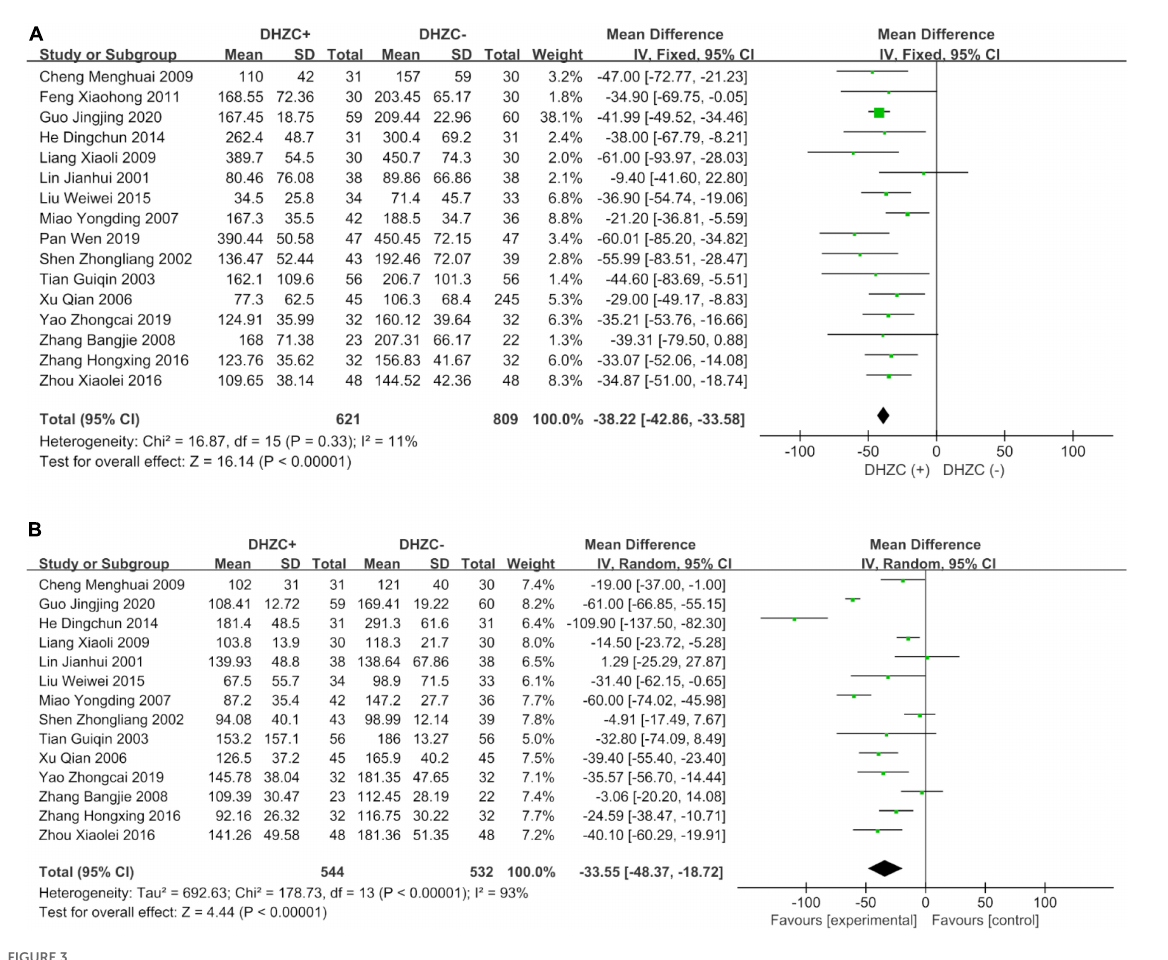
FIGURE3 The effect of Dahuang Zhechong pill (DHZCP)-based therapy on hyaluronic acid (HA) and laminin (LN). Fixed-effects models were applied in panel (A) . Random-effects models were applied in panel (B) . (A) Total HA; (B) Total